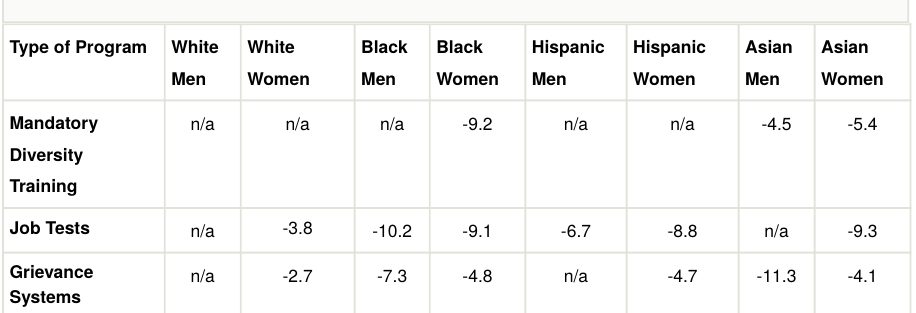
E ff ects of Traditional Diversity Training in the Workplace: % Change Over Five Years in Representation Among